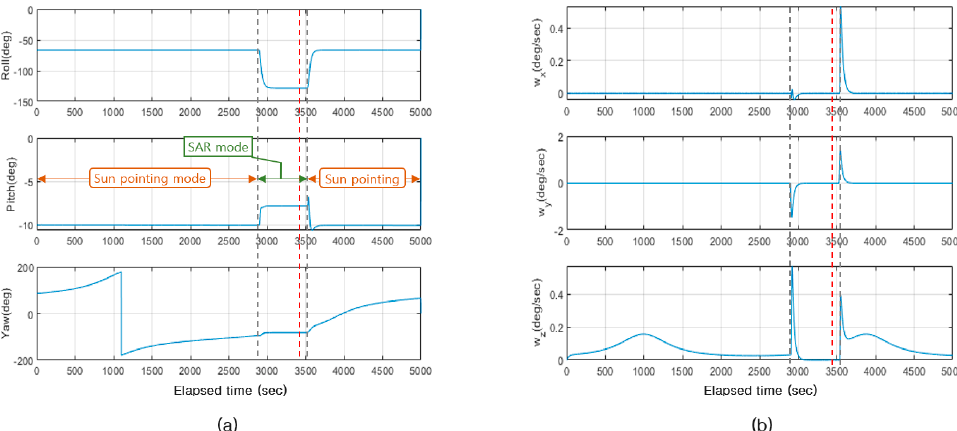
Figure 15. Attitude control simulation results: Euler angle with respect to the ECI frame ( a ) and angular velocity ( b ) of chief satellite. The red dotted line represents epoch SAR .